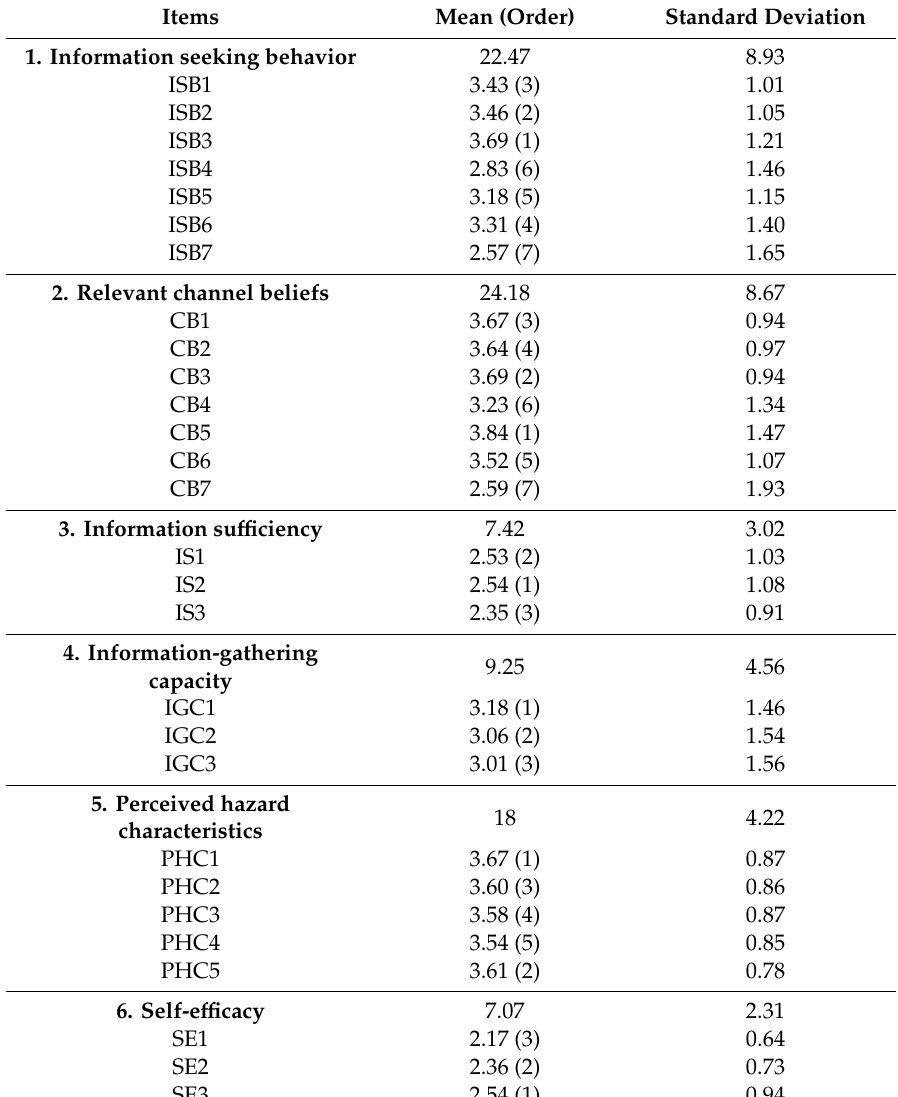
Table 6. Descriptive statistical results of